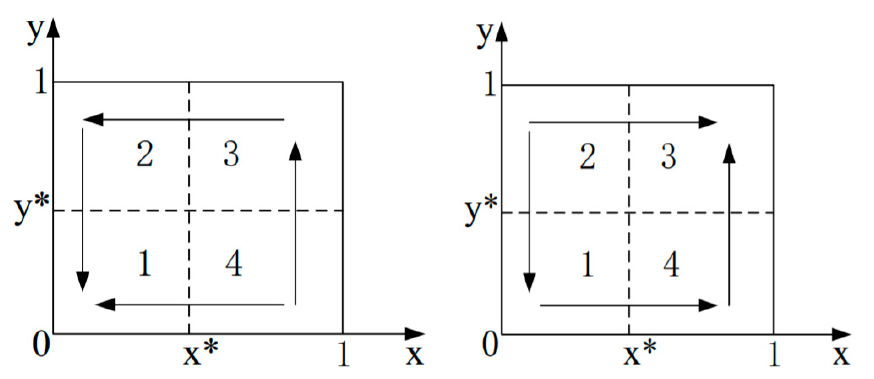
Figure 5. Copy dynamic phase diagram during development.